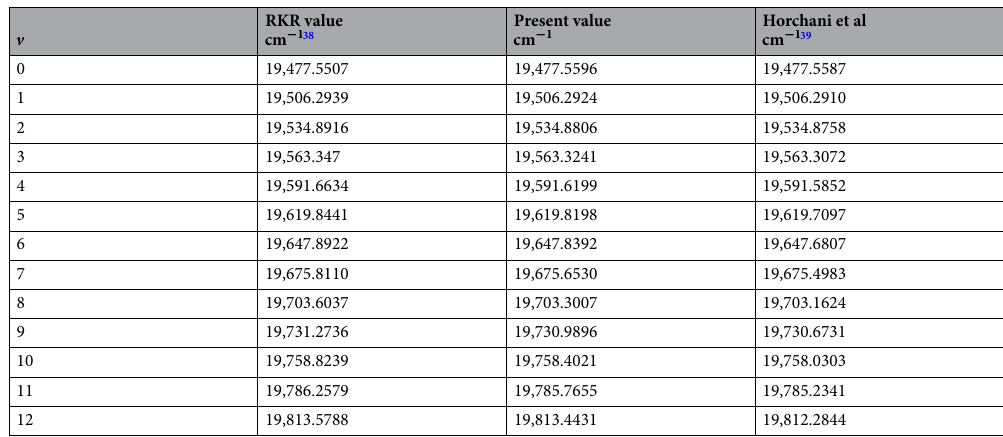
Table 3. Comparison of RKR data with calculated energies for Cs